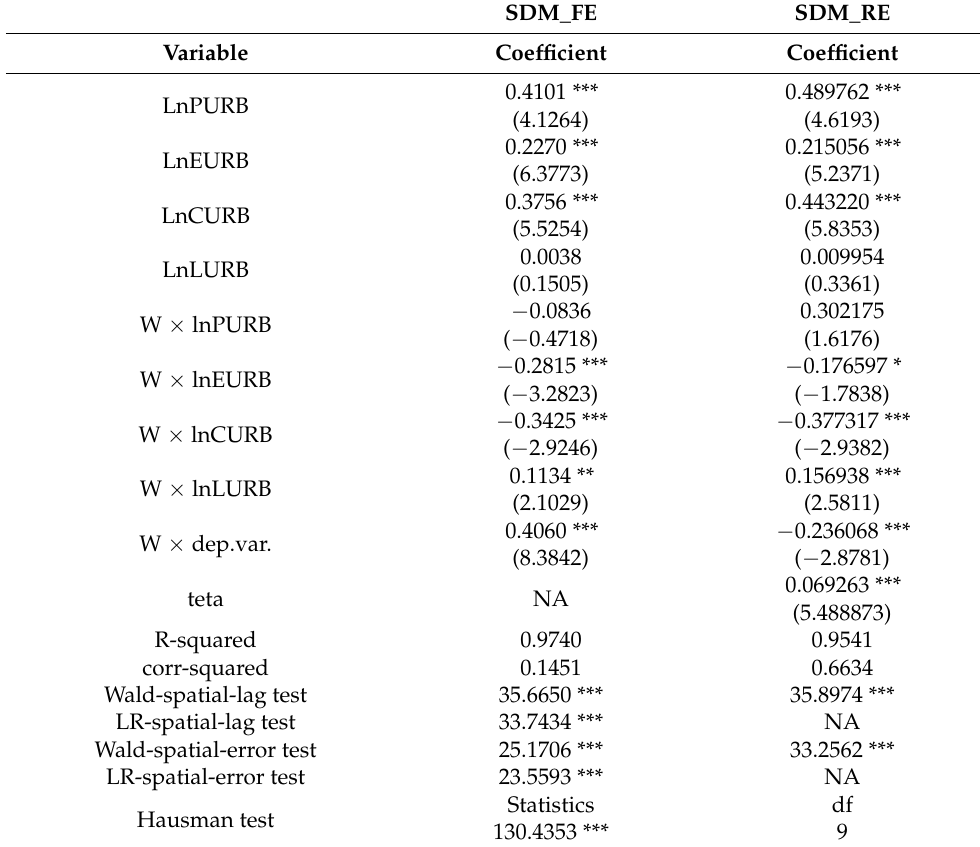
Table 17. SDM with fixed effect and random Effect.